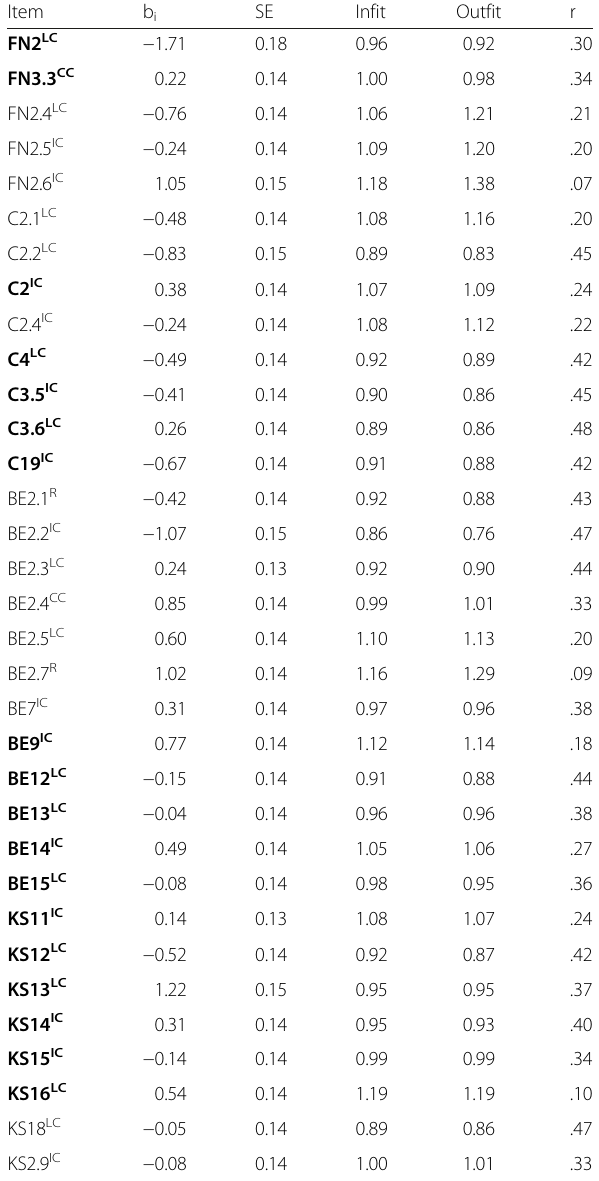
Table 5 Psychometric properties of the items of the TRC-e-2 (33